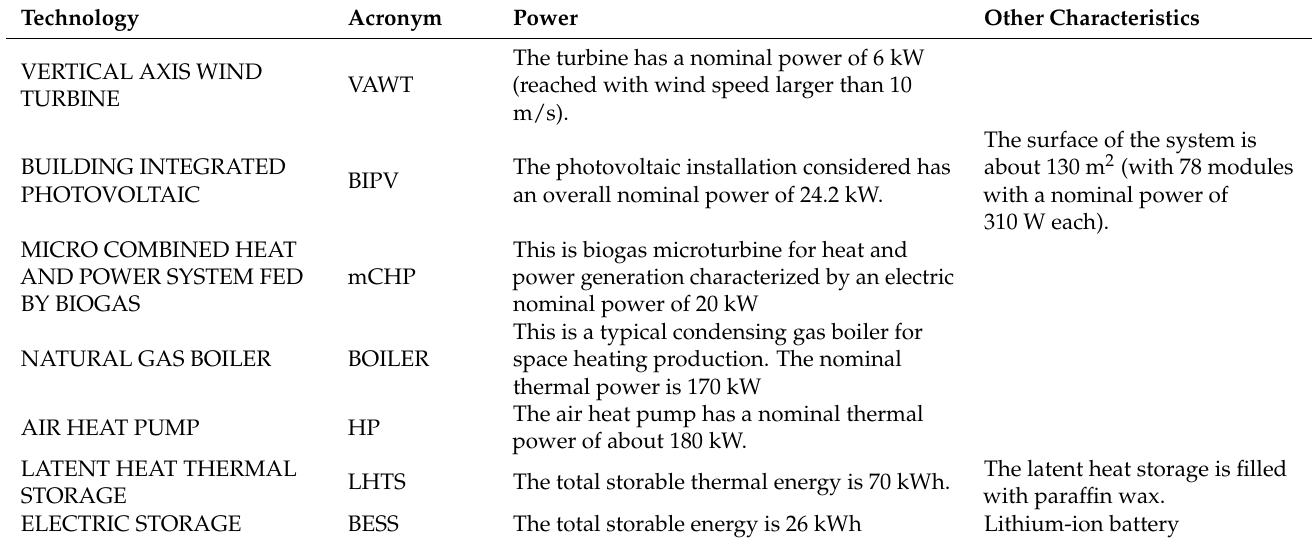
Figure 7. System layout Case 2. The characteristics of the technologies considered for the present work are reported in Table 2. The nominal power values are estimating by research that considers the data that are available for the various technologies, the common practice in the design of RES, and a preliminary simulation that allows the estimation of the device size.